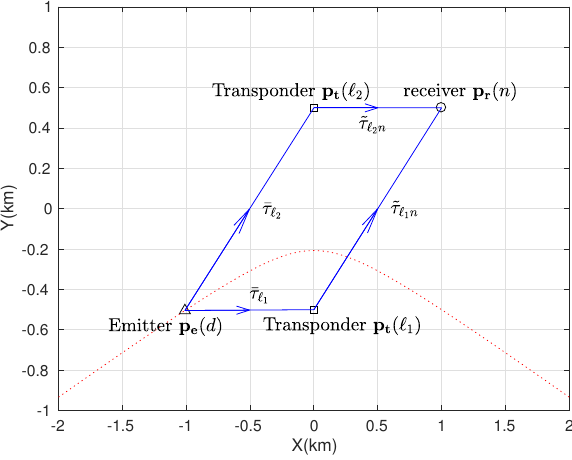
Figure A1. Two paths with the same